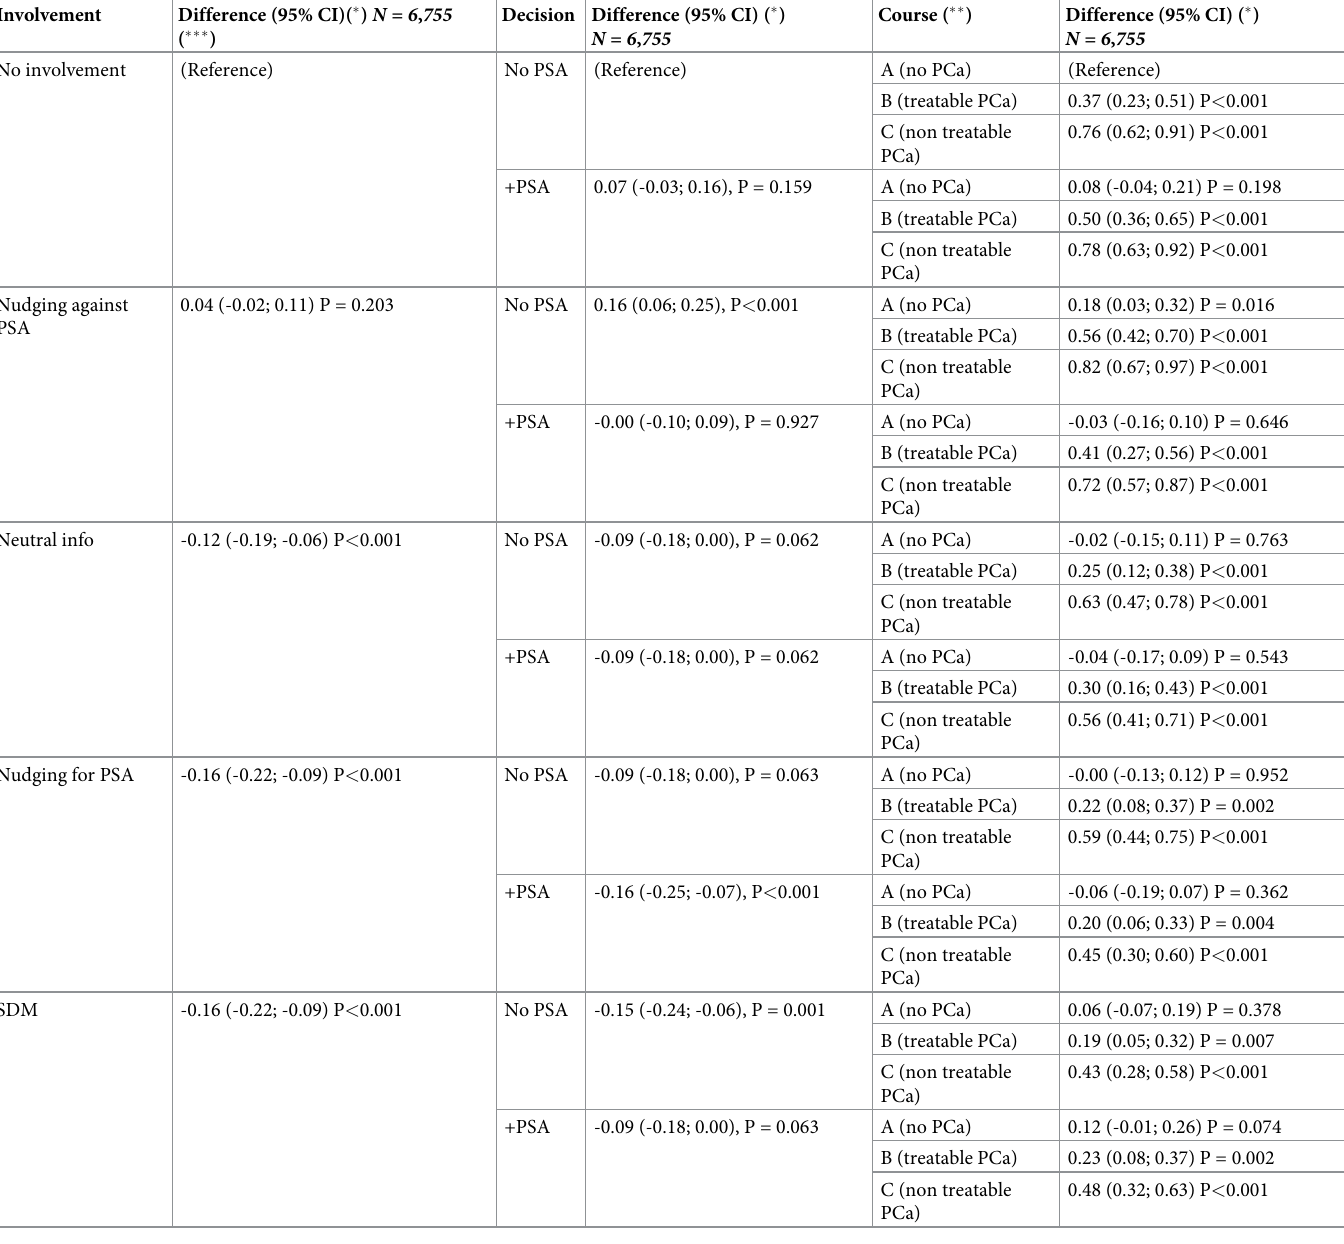
Table 3. Group differences in respondents’ wish to complain, different levels of involvement, decisions and